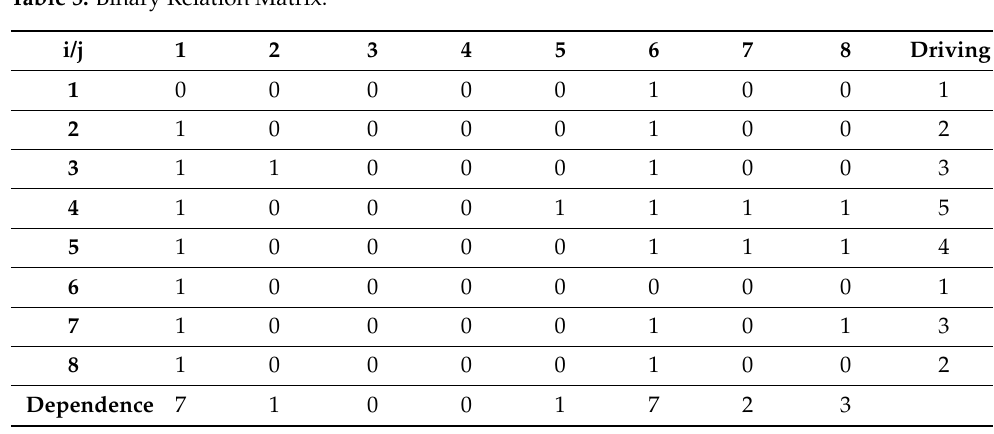
Table 5. Binary Relation Matrix.